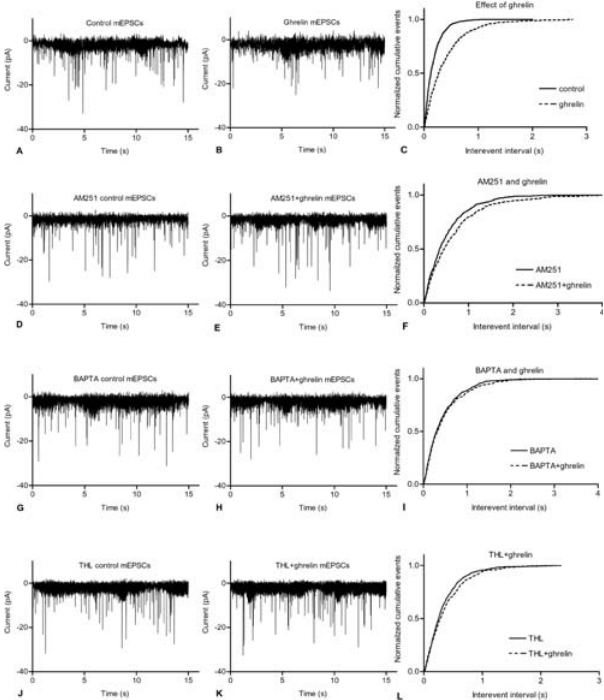
Figure 2. Whole-cell patch clamp recordings of mEPSCs in the parvocellular neurons of the PVN. Application of ghrelin (100 nM) in the extracellular solution decreased the amplitude and frequency of the mEPSCs (Fig. 2A–C). Extracellular administration of the cannabinoid receptor antagonist AM251 (1 m M), however, blocked the effect of ghrelin. Both amplitude and frequency changes were attenuated (Fig. 2D–F). In addition, intracellularly applied BAPTA, an effective chelator of free calcium, (Fig. 2G–I) and the DAG lipase (DAGL) inhibitor THL (5 m M) (Fig. 2J–L) also abolished the effect of ghrelin.